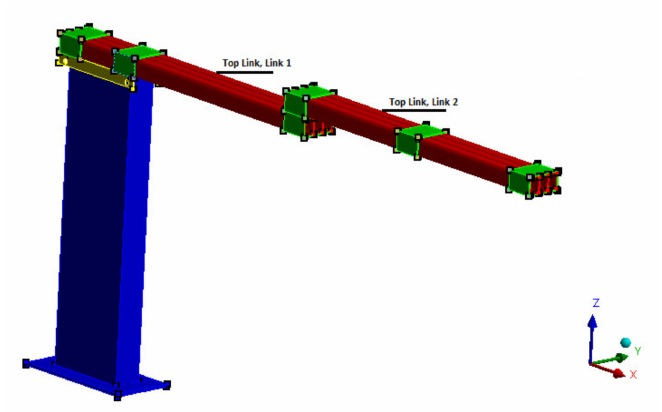
Figure 10. 5-DOF robot manipulator used in plant